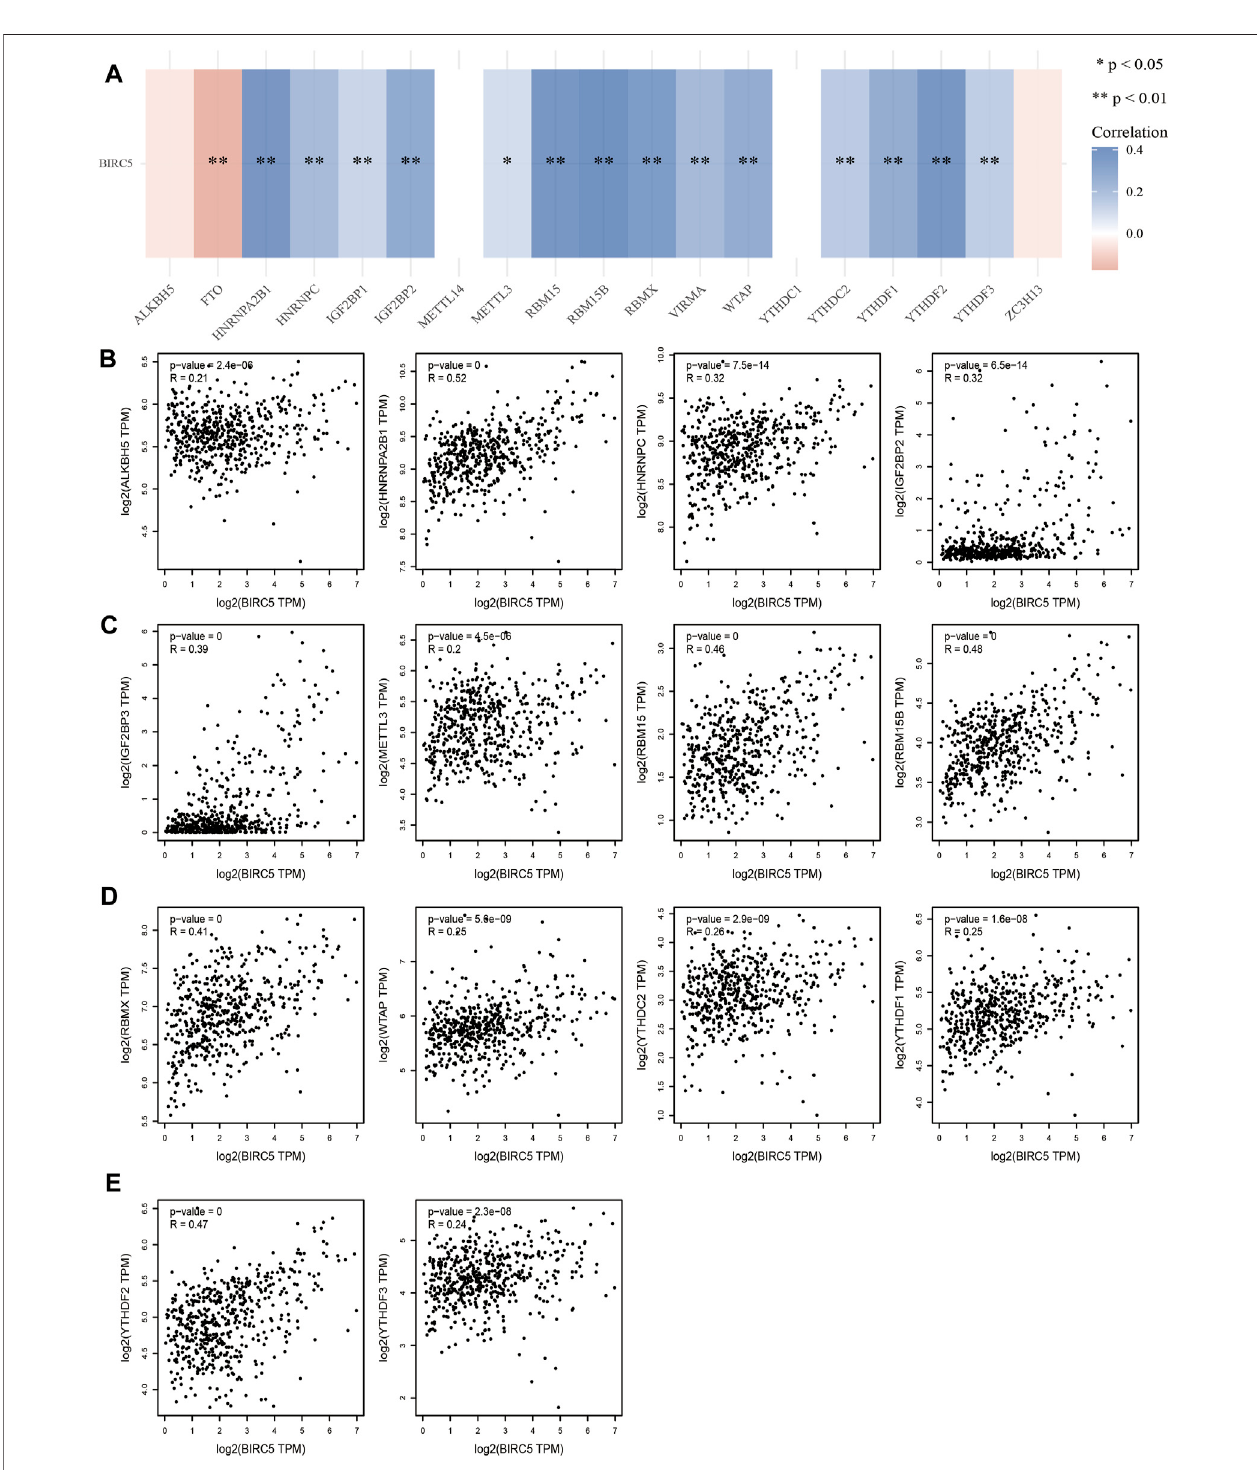
FIGURE 5 | Analysis of the correlation between BIRC5 expression and m6A regulator in LGG. (A – E) Analysis of the correlation between BIRC5 expression and m6A regulator in low grade glioma by Pearson ’ s correlation.